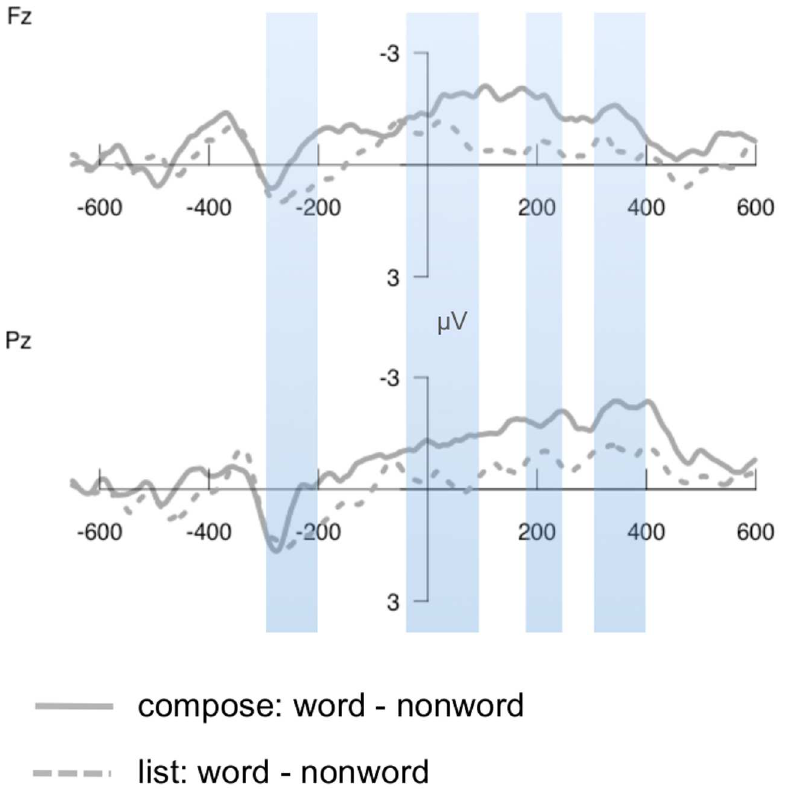
Fig 5. ERP difference waveforms. The upper panel shows the difference between word and nonword responses(word—nonword) at electrode Fz, and the bottom panel shows the difference at electrode Pz.